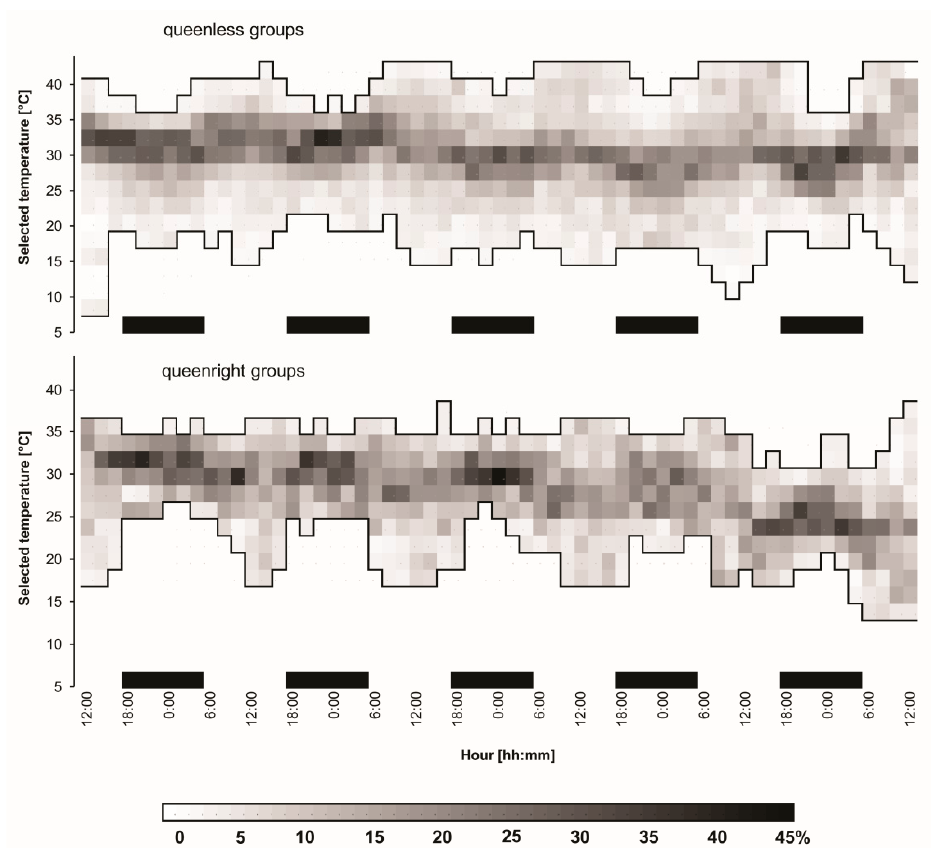
Figure 4. A diagram illustrating the dynamics of worker bees’ clustering behavior in queenless and queenright groups of the bees over four-day recording period. The small squares filled with different grades of grey indicate percentage of the groups’ members clustering together at particular temperature points of the gradient chambers. The percentage scale of the clustering is presented at the bottom of the figure.